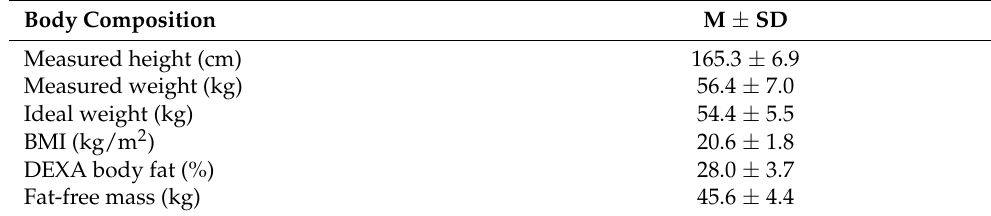
Table 5. Self-reported and measured physical measurements for dancers ( n = 28).